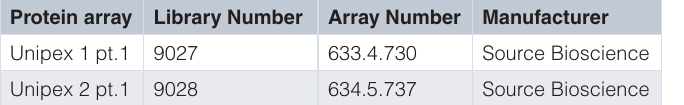
Table 2. Details of protein